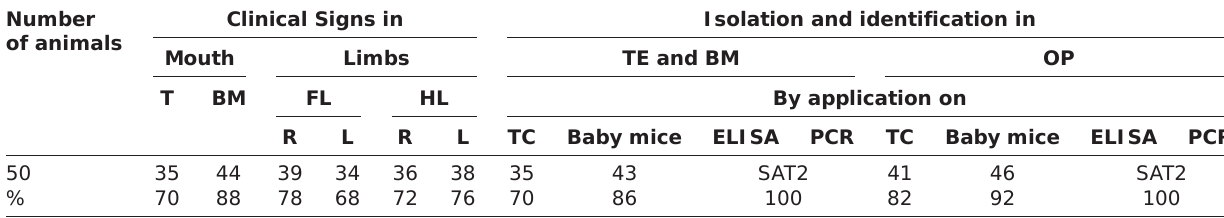
Table-1: Clinical signs; isolation and identification of FMDV from naturally infected pregnant buffalo. Number Clinical Signs in of animals